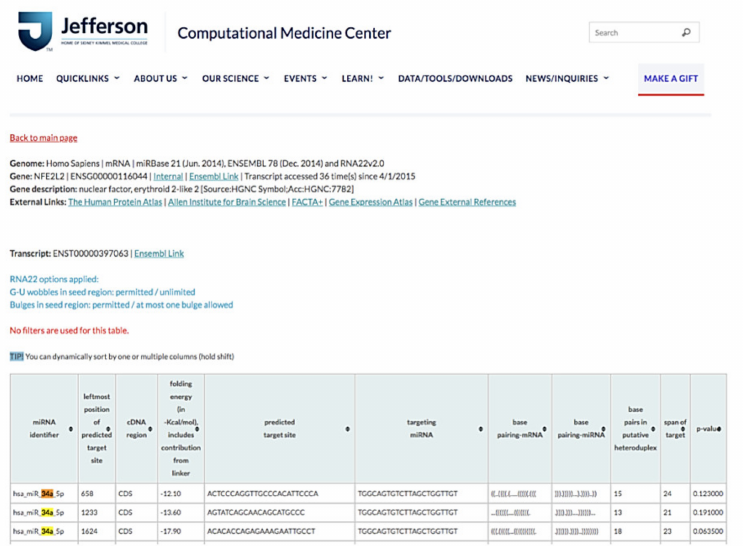
Figure 8. miR-34a-5p interacted with NFE2L2 mRNA to promote its posttranscriptional degradation. Based on RNA22 prediction, the CDS of human NFE2L2 contains one potential seed site for hsa-miR- 34a-5p